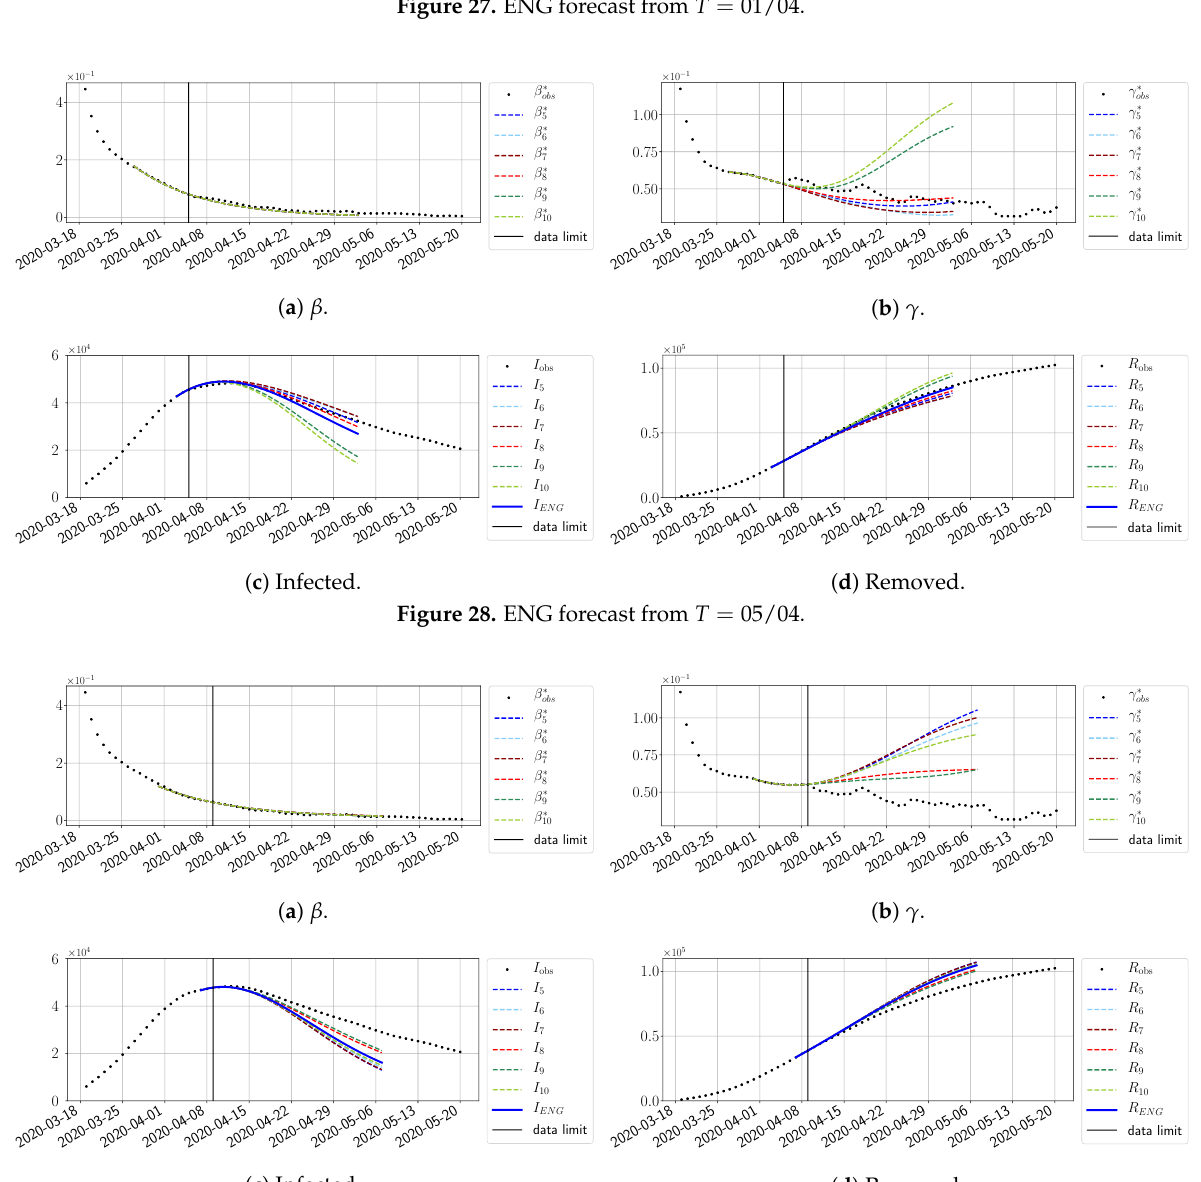
Figure 27. ENG forecast from T = 01/04.